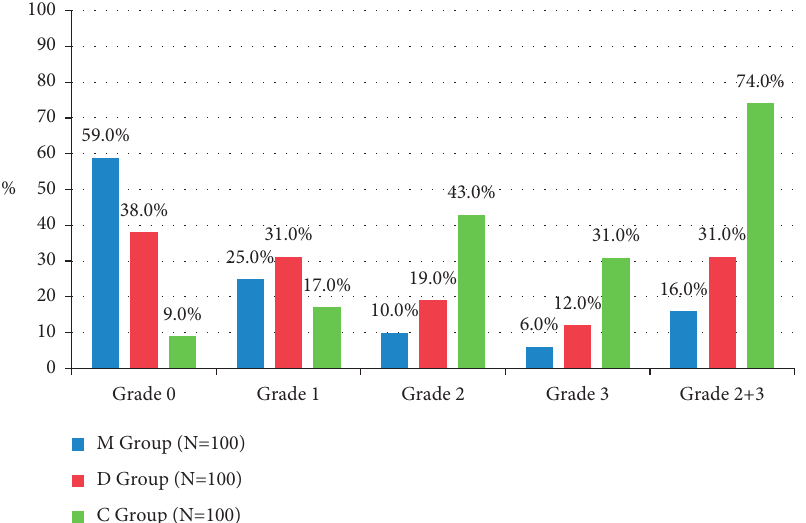
Figure 6: Patients’ percentages of different grades of shivering after 90 minutes of subarachnoid